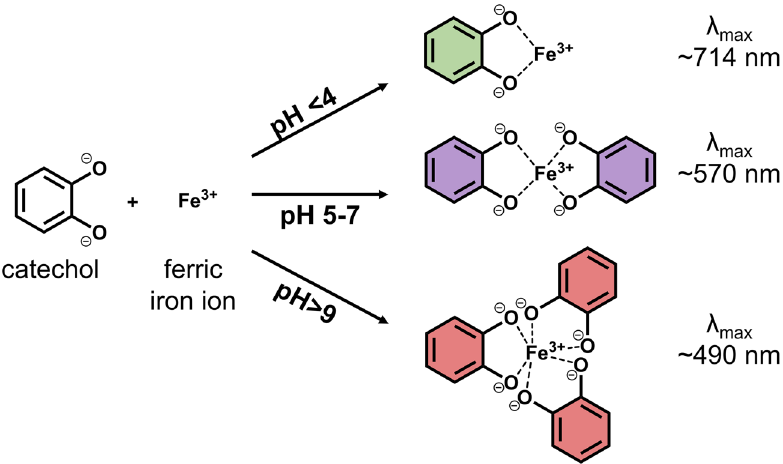
Figure 1. Coordination of ferric iron by catechol at different pH values and corresponding maximum absorbance ( λ max ) resulting from ligand-to-metal charge transfer (based on 7,12